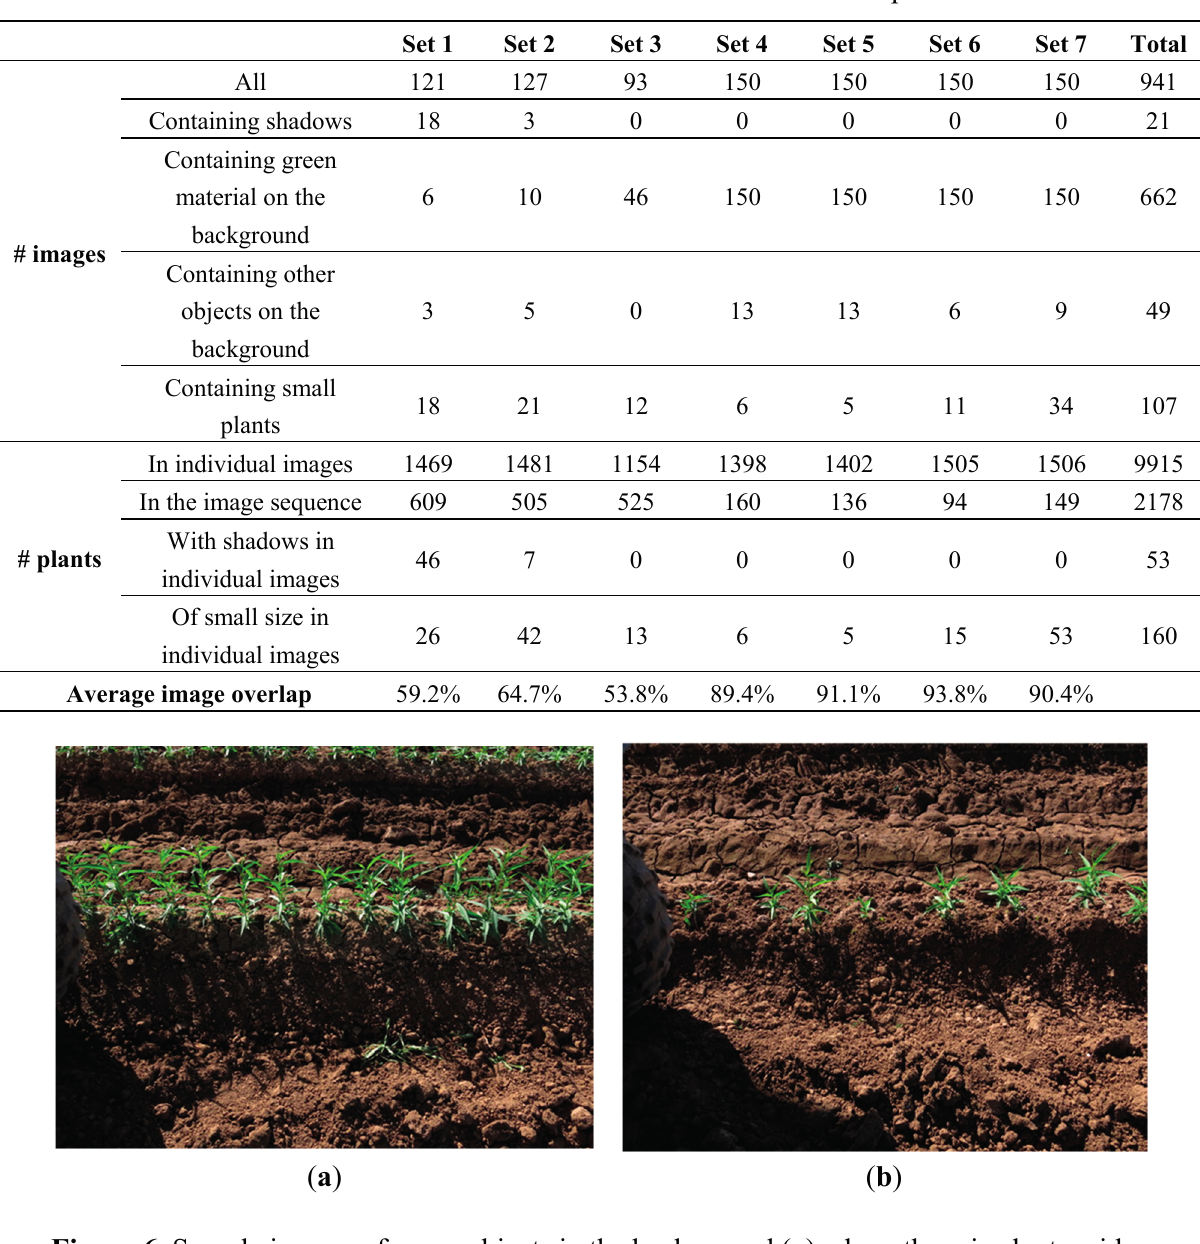
Figure 6. Sample images of green objects in the background ( a ) where there is plant residue on the soil and plants in the next row; and small plants ( b